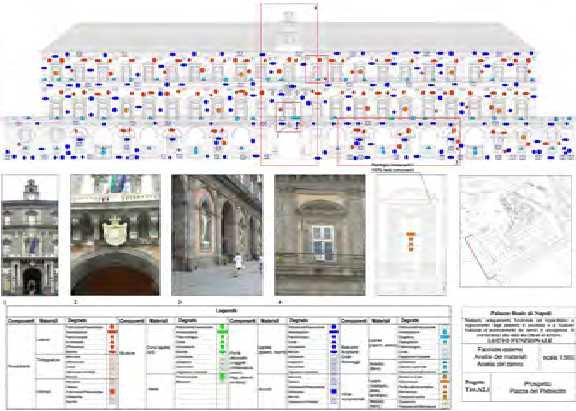
Figure 2. Example of Table of